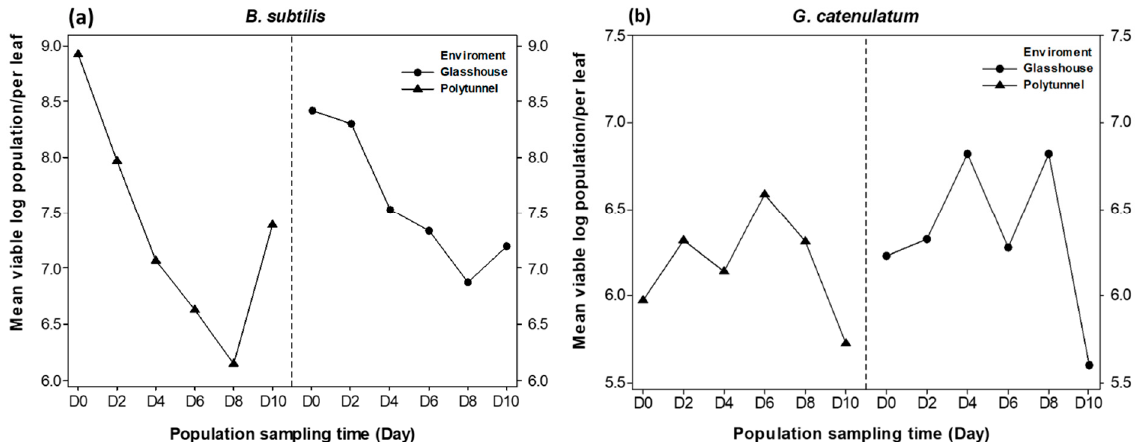
Figure 7. ( a ) Temporal viable population of B. subtilis in glasshouse and polytunnel grown lettuce; ( b ) the temporal viable population of G. catenulatum in glasshouse and polytunnel grown lettuce. The standard errors were <1.25.